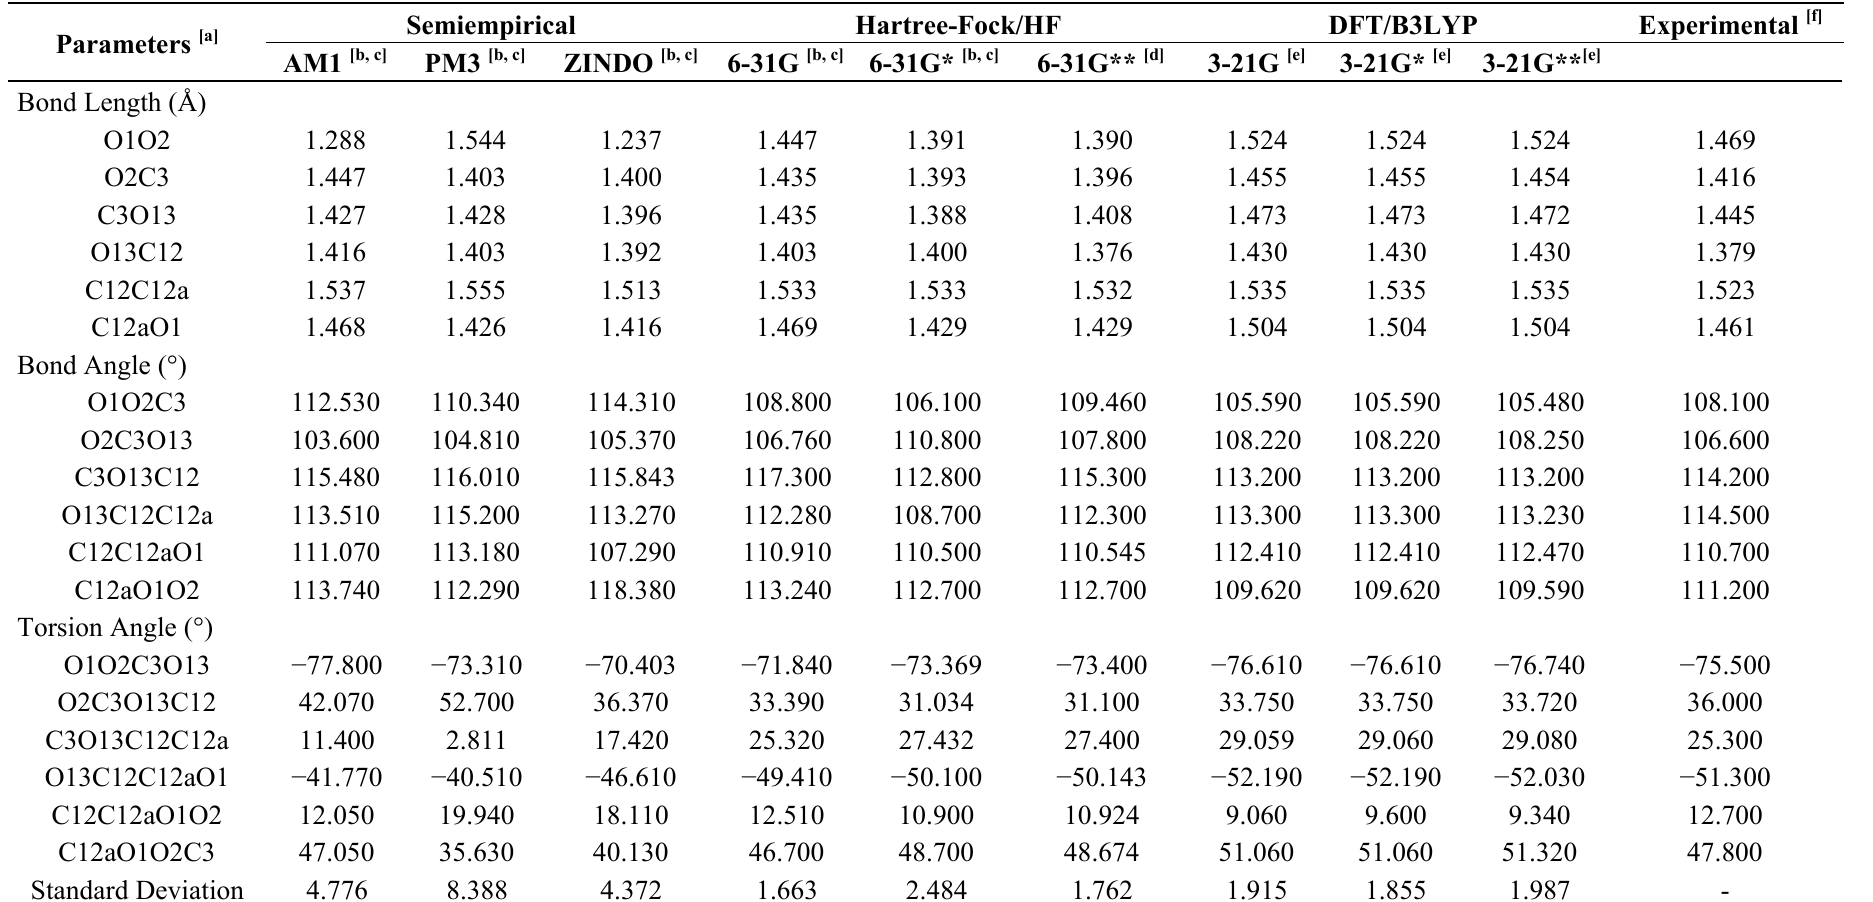
Table 1. Theoretical and experimental parameters of the 1, 2, 13-trioxane ring in